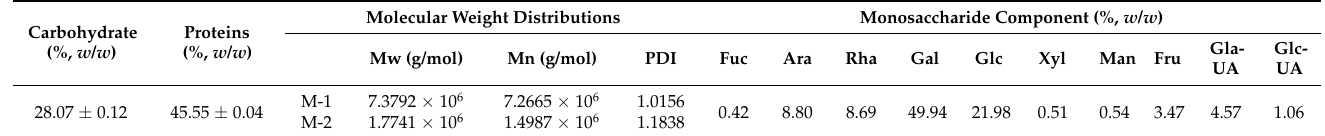
Figure 7. GPC raw data graph: the red line represents M-1 and the blue line represents M-2, which indicate the two molecular weight distributions of FS. Table 1. Composition and characteristics of FS.